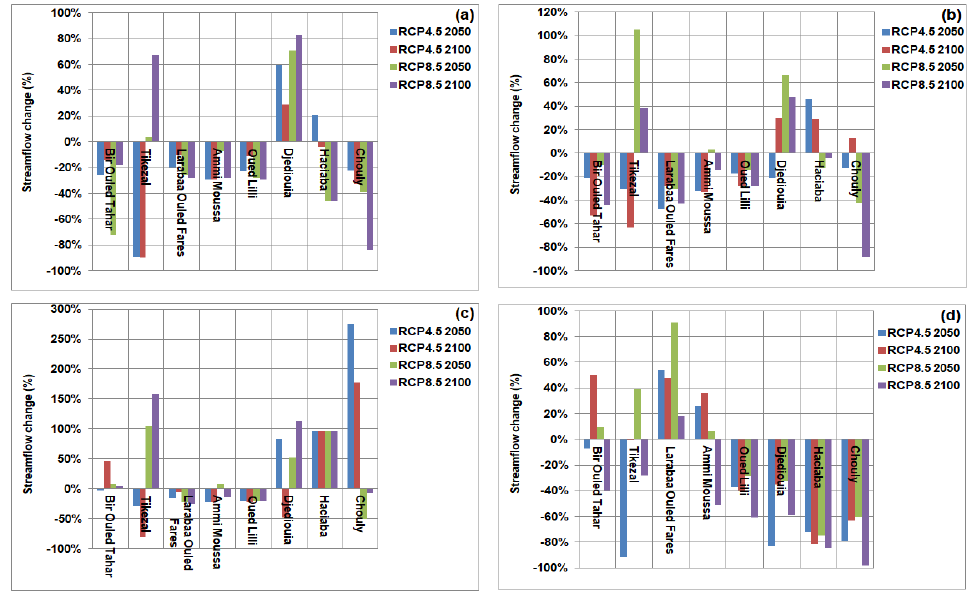
Figure 9. Changes in winter streamflow relative to the historical period under two scenarios (RCP4.5 and RCP8.5): ( a ) quantile mapping, ( b ) scaled distribution mapping, ( c ) quantile delta mapping, and ( d ) model RAW.